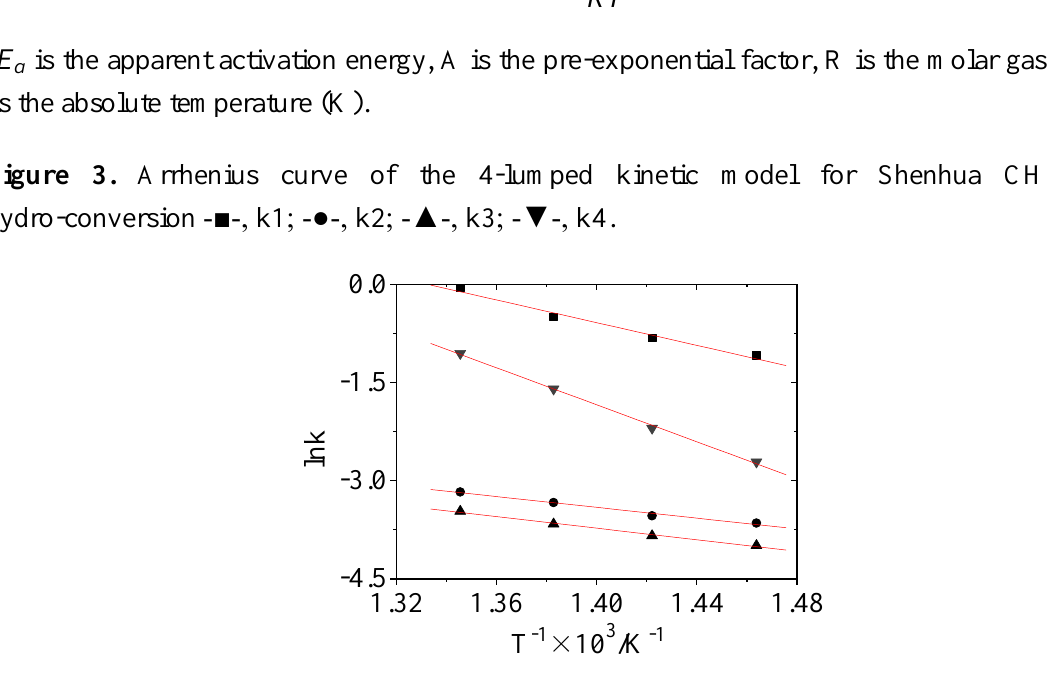
Table 2. Kinetic parameters of the 4-lumped model for Shenhua CHLR hydro-conversion.